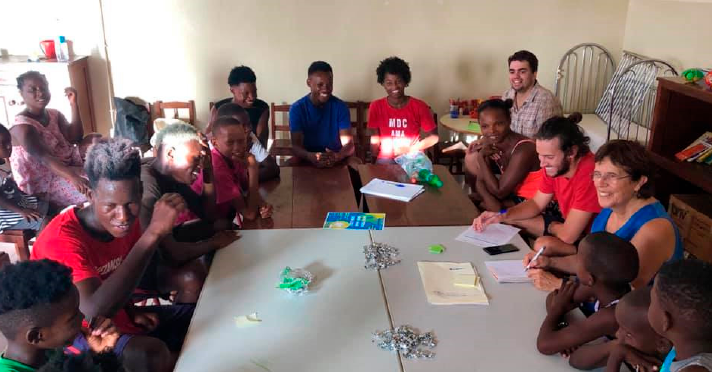
Figure A3. Active listening and brainstorming in the participatory session in Porto Gouveia. (photos by the authors, September 2019).